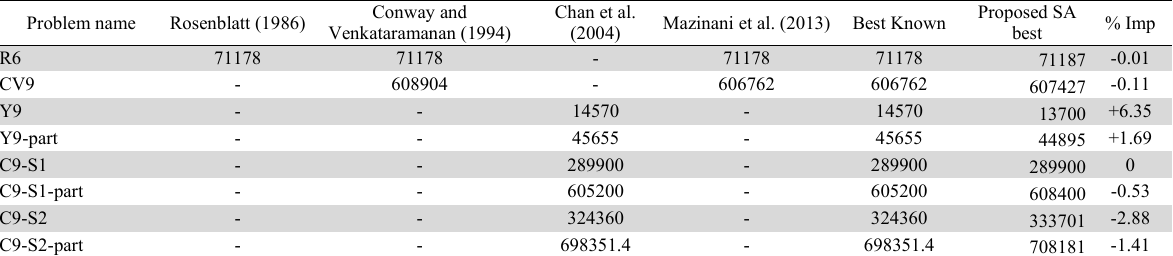
Comparison of proposed SA heuristic solution value with the other adaptive approaches solution values for equal area